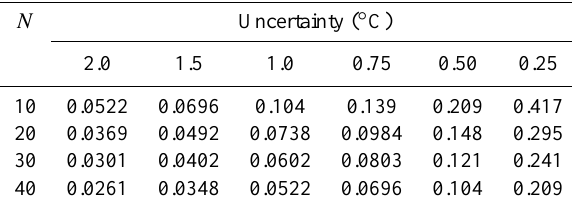
Table 6. Sensitivity ( b in Eq. 1) as a function of a given uncertainty in reconstructed temperature and number of specimens ( N ) used for Mg/Ca analyses. Uncertainty is expressed as a range (max–min) around the average reconstructed temperature.